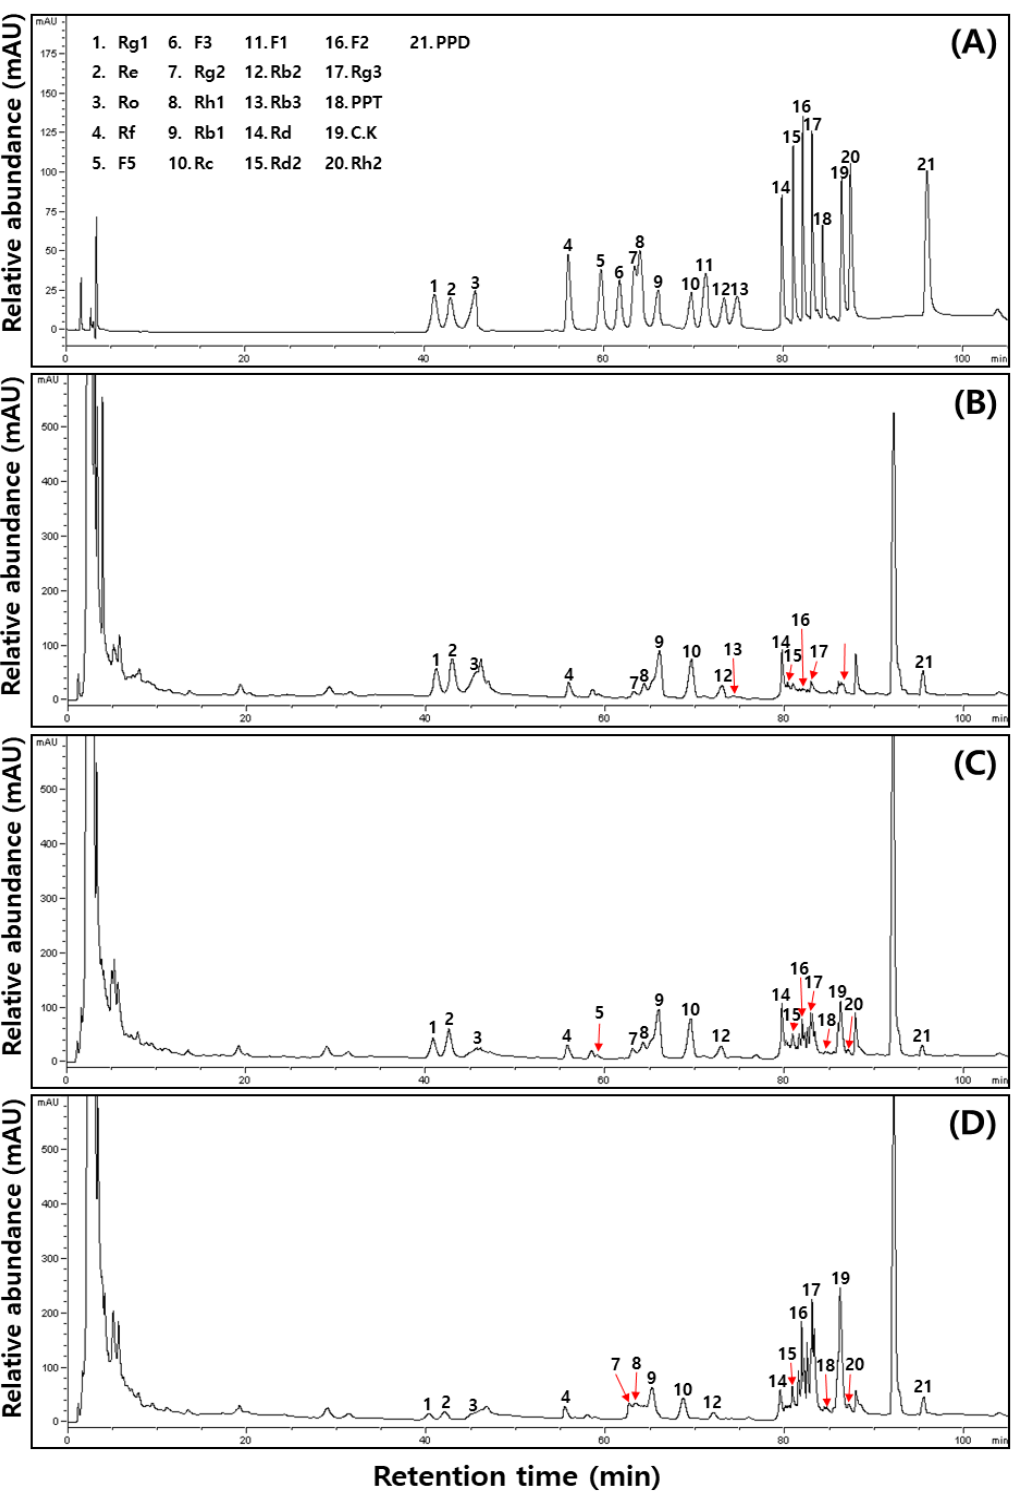
Figure 4. Typical ginsenosides HPLC chromatogram of the 50% ethanol extracts during food processing steps of mountain-cultivated ginseng by the cocktail lactic acid bacteria. ( A ) Standard; ( B ) 50% ethanol extract of dry mountain-cultivated ginseng (DMCG); ( C ) 50% ethanol extract of red mountain-cultivated ginseng (RMCG); and ( D ) 50% ethanol extract of fermented red mountain-cultivated ginseng (FRMCG).